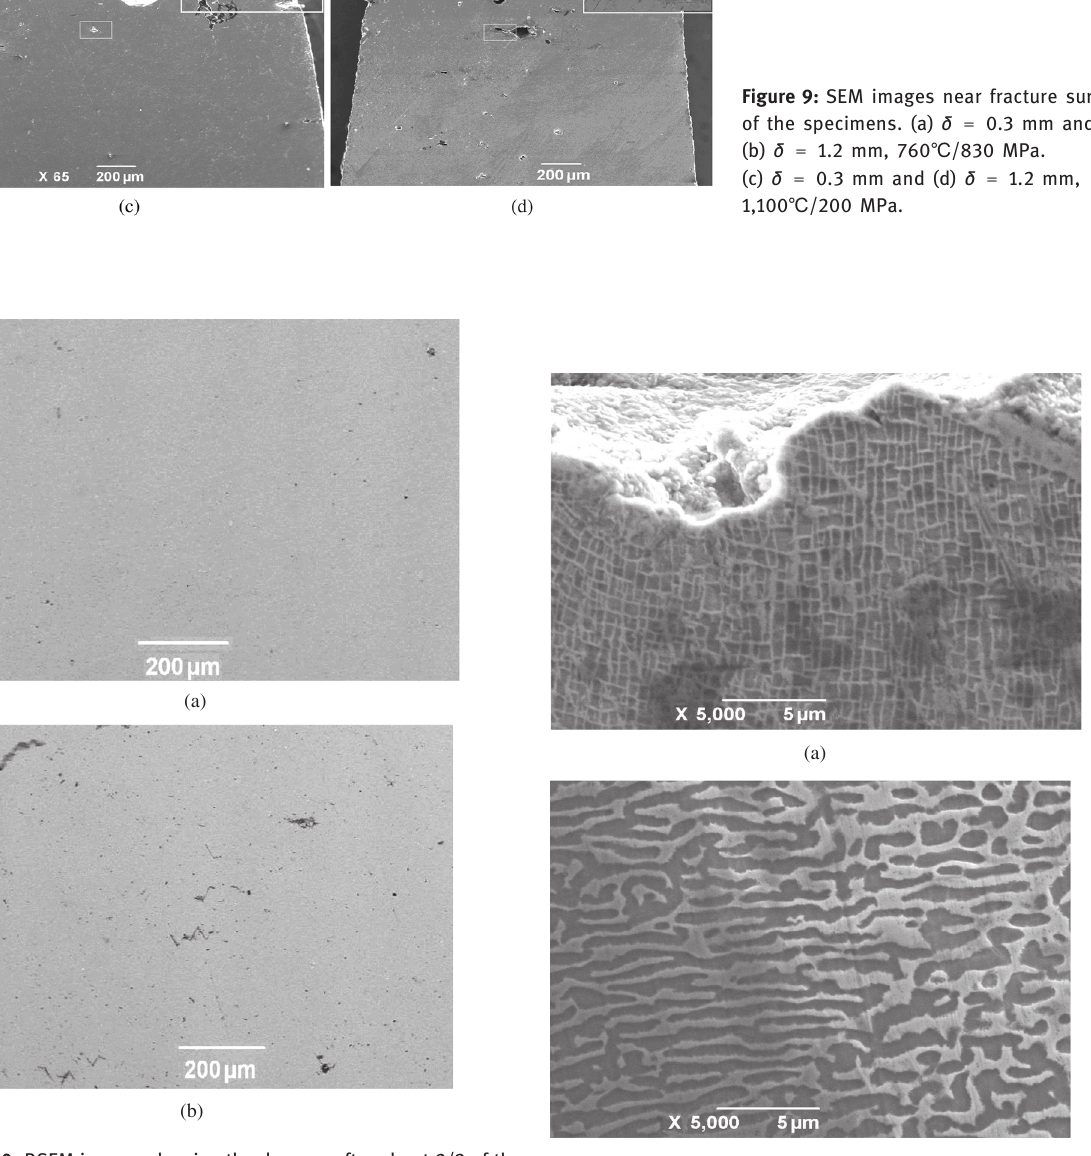
Figure 10: BSEM images showing the damage after about 2/3 of the whole creep life. (a) A δ = 1.2 mm thick specimen after 55 h tested at 980 ℃ /320 MPa. (b) A δ = 1.2 mm thick specimen after 16 h tested at 1,100 ℃ /200 MPa.